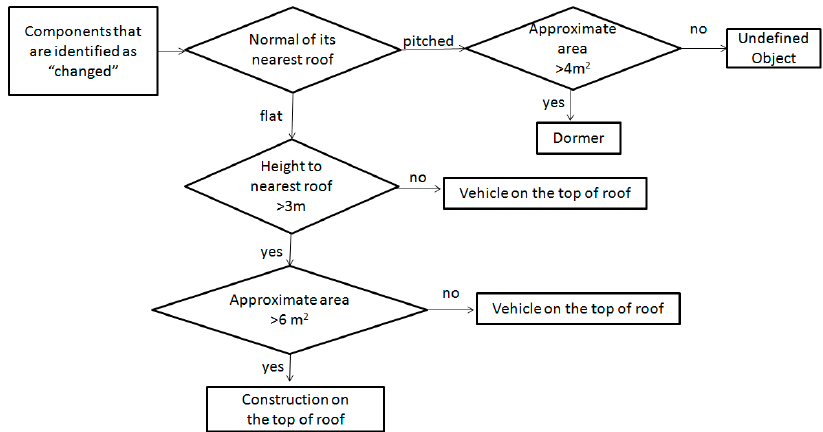
Figure 8. Rule-based classification of changes.